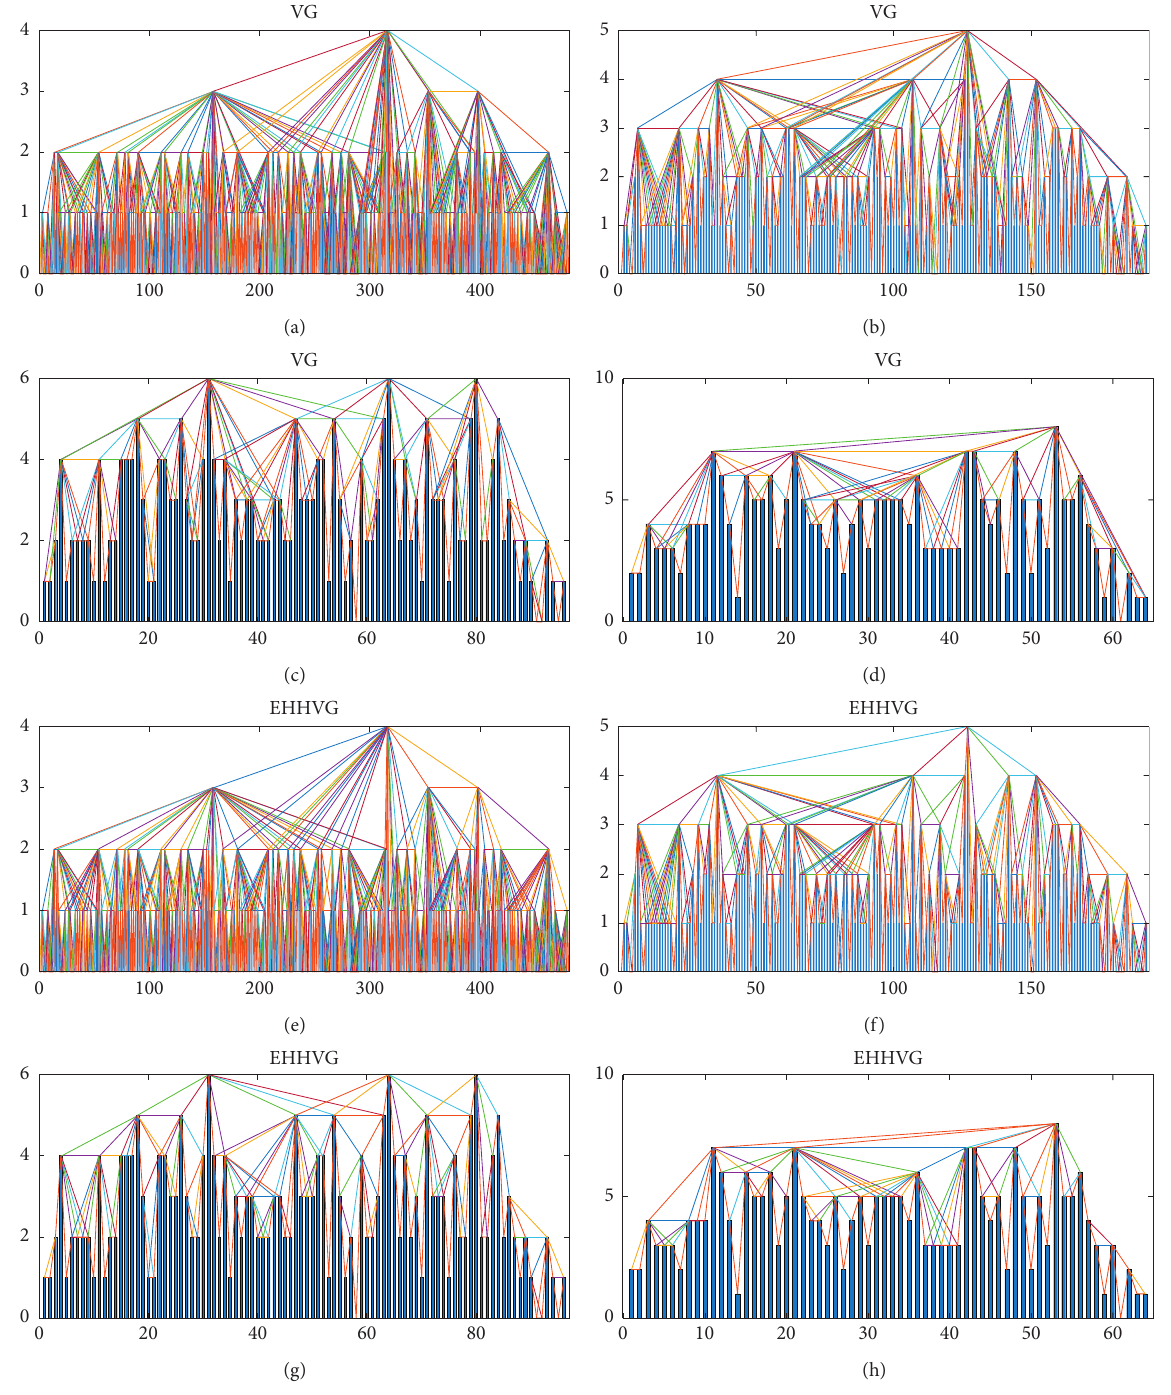
Figure 14: Equal height horizontal visibility graph of the sample. (a) Δ t � 2min. (b) Δ t � 5min. (c) Δ t � 10min. (d) Δ t � 15min. (e) Δ t � 2min. (f) Δ t � 5min. (g) Δ t � 10 min. (h) Δ t �